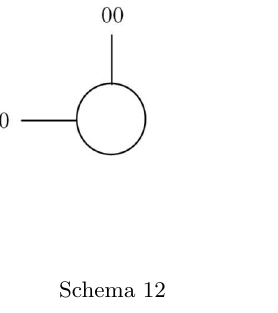
Schema 12 stands for a two-place basic formula: ⌊ p q ⌋ (pq), which means the whole expression is true iff ‘p’ is true (has value 1) and ‘q’ is false (has value 0), or both ‘p’ and ‘q’ are false. Graph 29 (also see graph 8(b), 8(c)) stands for an assertion: ⊢ ¬ q. It means that ‘q’ is false (has value 0) whether ‘p’ is true or not, or that ‘ ¬ q’ is true whether ‘p’ is true or not.